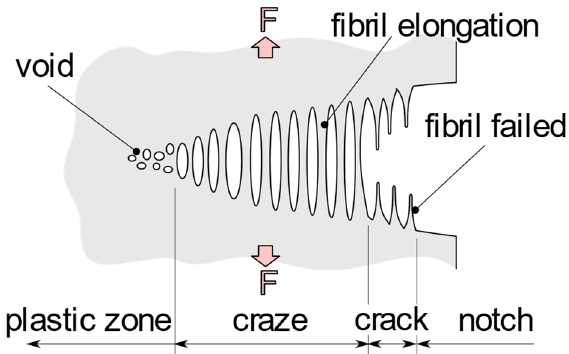
Figure 1. Schematic illustration of the process zone at the notch root or crack tip. Initiation of voids in the plastic zone by stress concentration at the crack tip due to external loading. Voids grow in a plane perpendicular to the direction of stress and form into fibrils that temporarily stabilize the craze zone. As the local stress in the fibrils increases, they fail and the craze–crack transition occurs. Craze–crack propagation right to left (remade after [17,25]).